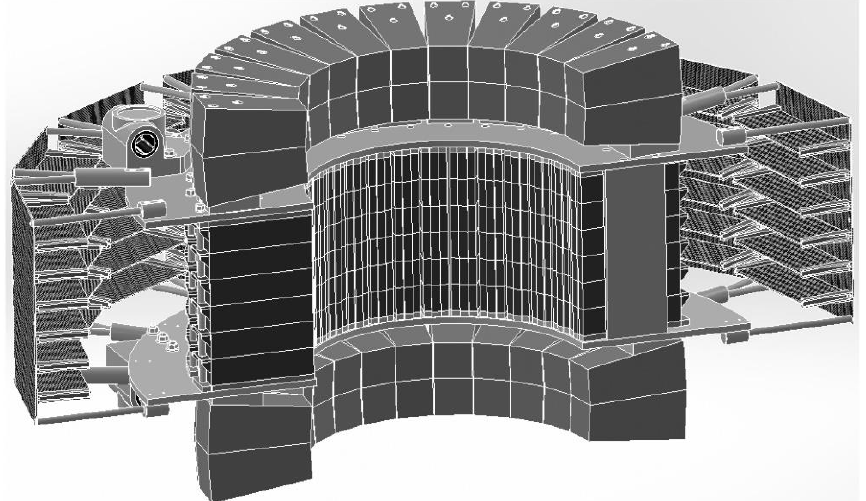
Figure 2. Diagram of SuperPEPT. Reprinted from [7], Copyright (2022), with permission from Elsevier.